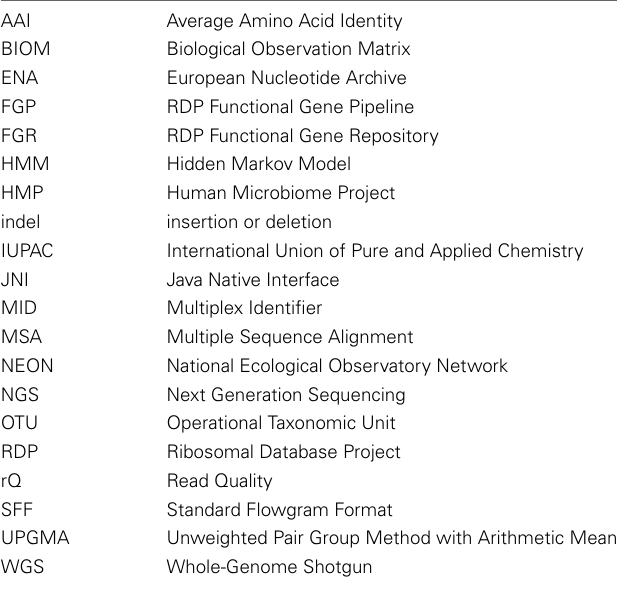
Table 1 | List of